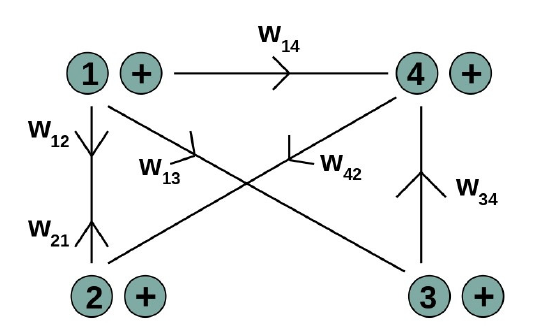
Figure 2: The figure illustrates an example of µ = 4 case where certain flips are activated between pairs of species by the impurity, whereas some of the flips are = 0. In this scenario, α absent e.g. w would be different for different pairs KI 24 ( I , K )